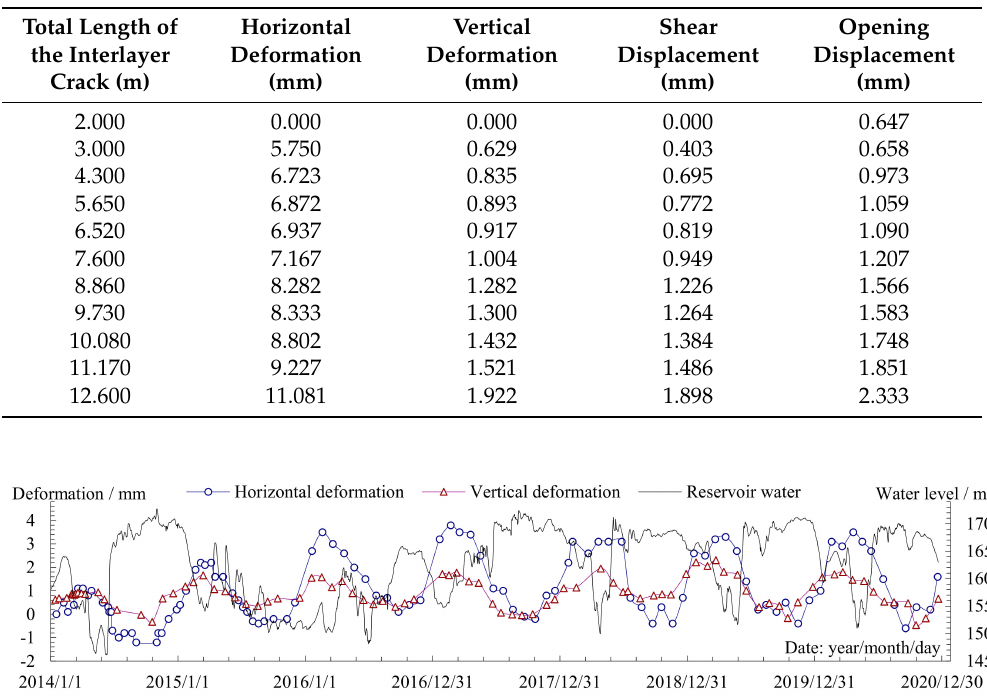
Table 2. The deformation of typical points during the crack propagation.